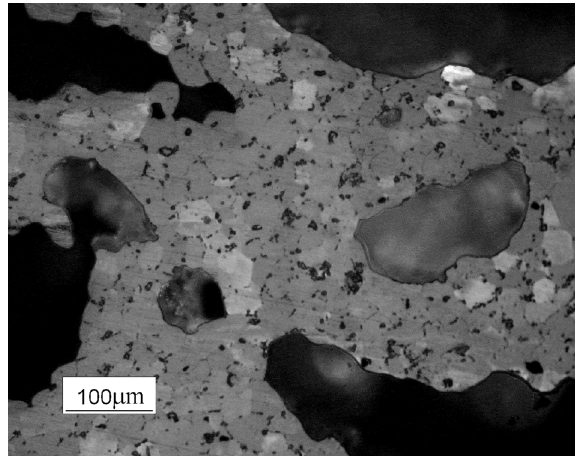
Figure 5. An optical micrograph showing the onset of melt- ing of the powder particles.